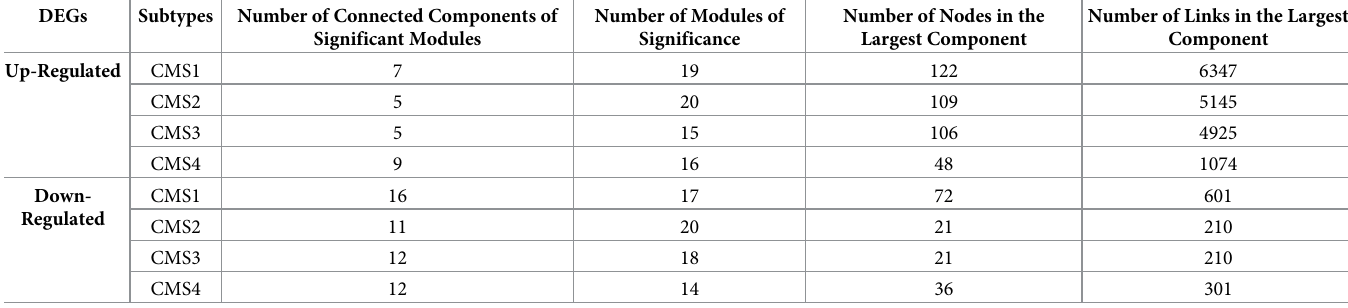
Table 1. Module configuration in each